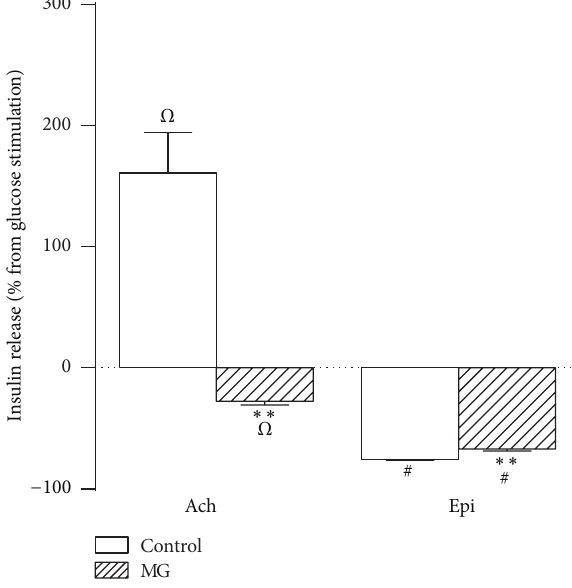
Figure 2: Effect of acetylcholine or epinephrine on GSIS. Insulin secretion was stimulated or inhibited by acetylcholine or epineph- rine, as indicated below the 𝑥 -axis, in absence or presence of methylglyoxal. Bars represent the mean ± S.E.M. of the percentage of insulin release compared with their respective glucose concen- trations, which are represented by the line from 0. Ach, 10 𝜇 M of acetylcholine in presence of 10 𝜇 M of neostigmine + 8.3 mM of glucose; Epi, 1 𝜇 M epinephrine + 16.7mM of glucose. Ω 𝑃 < 0.001 compared with 8.3 mM of glucose; # 𝑃 < 0.001 compared with 16.7 mM of glucose; ∗ 𝑃 < 0.05 and ∗∗ 𝑃 < 0.001 compared with the respective control